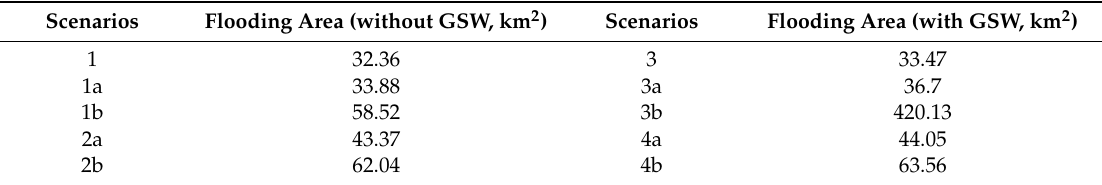
Table 3. Flooding areas of Jakarta Bay due to sea level rise and river